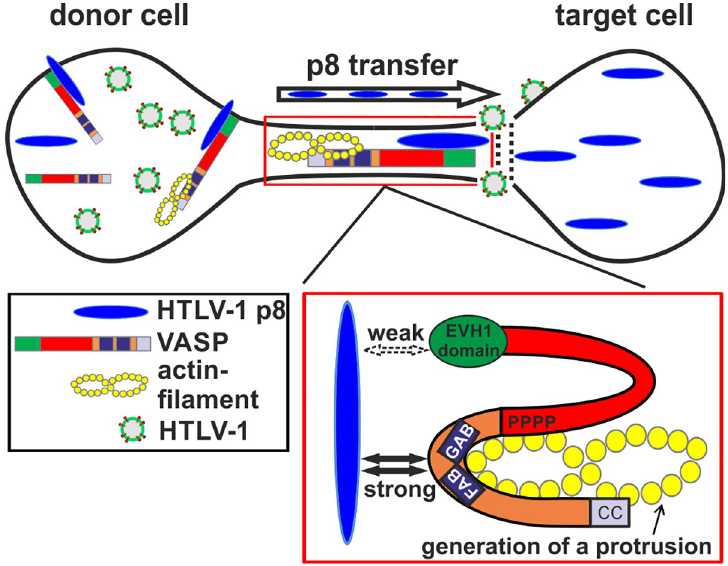
Fig 11. Model of the VASP:p8 interaction and its role in p8 transfer and HTLV-1 transmission. Our data suggest a weak interaction between the EVH1 domain of VASP and p8, which may be important for the recruitment of VASP, and a strong interaction of the G- and F-actin binding site of VASP with p8. Transfer of p8 and of Gag p19, and thus, presumably of HTLV-1 to target cells depends on VASP and may be driven by formation of a VASP- and actin- containing cellular